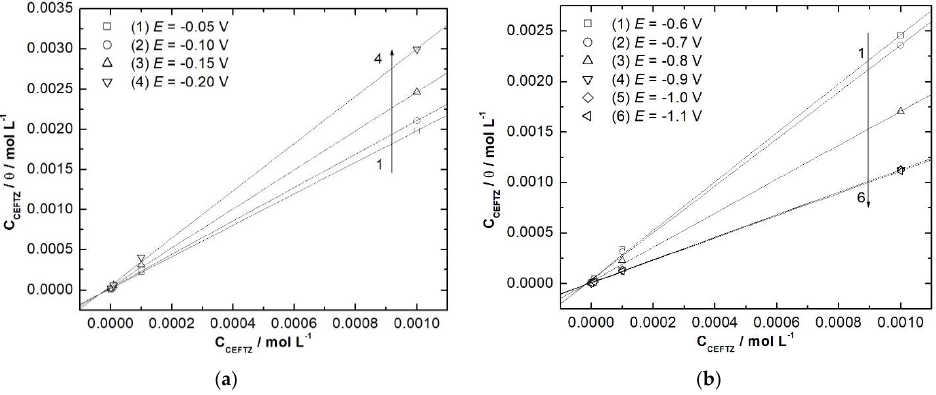
Figure 7. Langmuir isotherms for copper ( a ) and nickel electrodeposition ( b ) at different potential values. Table 4. Gibbs free energy for nickel and copper deposition at different potentials.